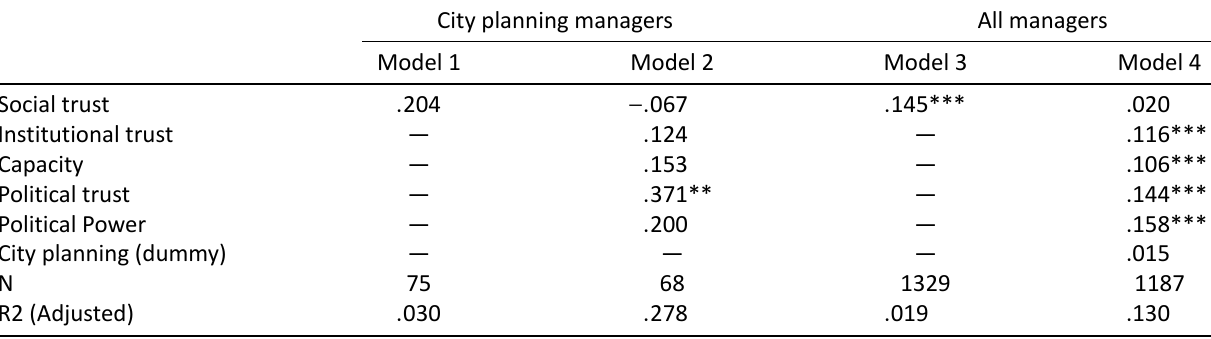
Table 3. Explaining public managers’ trust in citizens (standardized